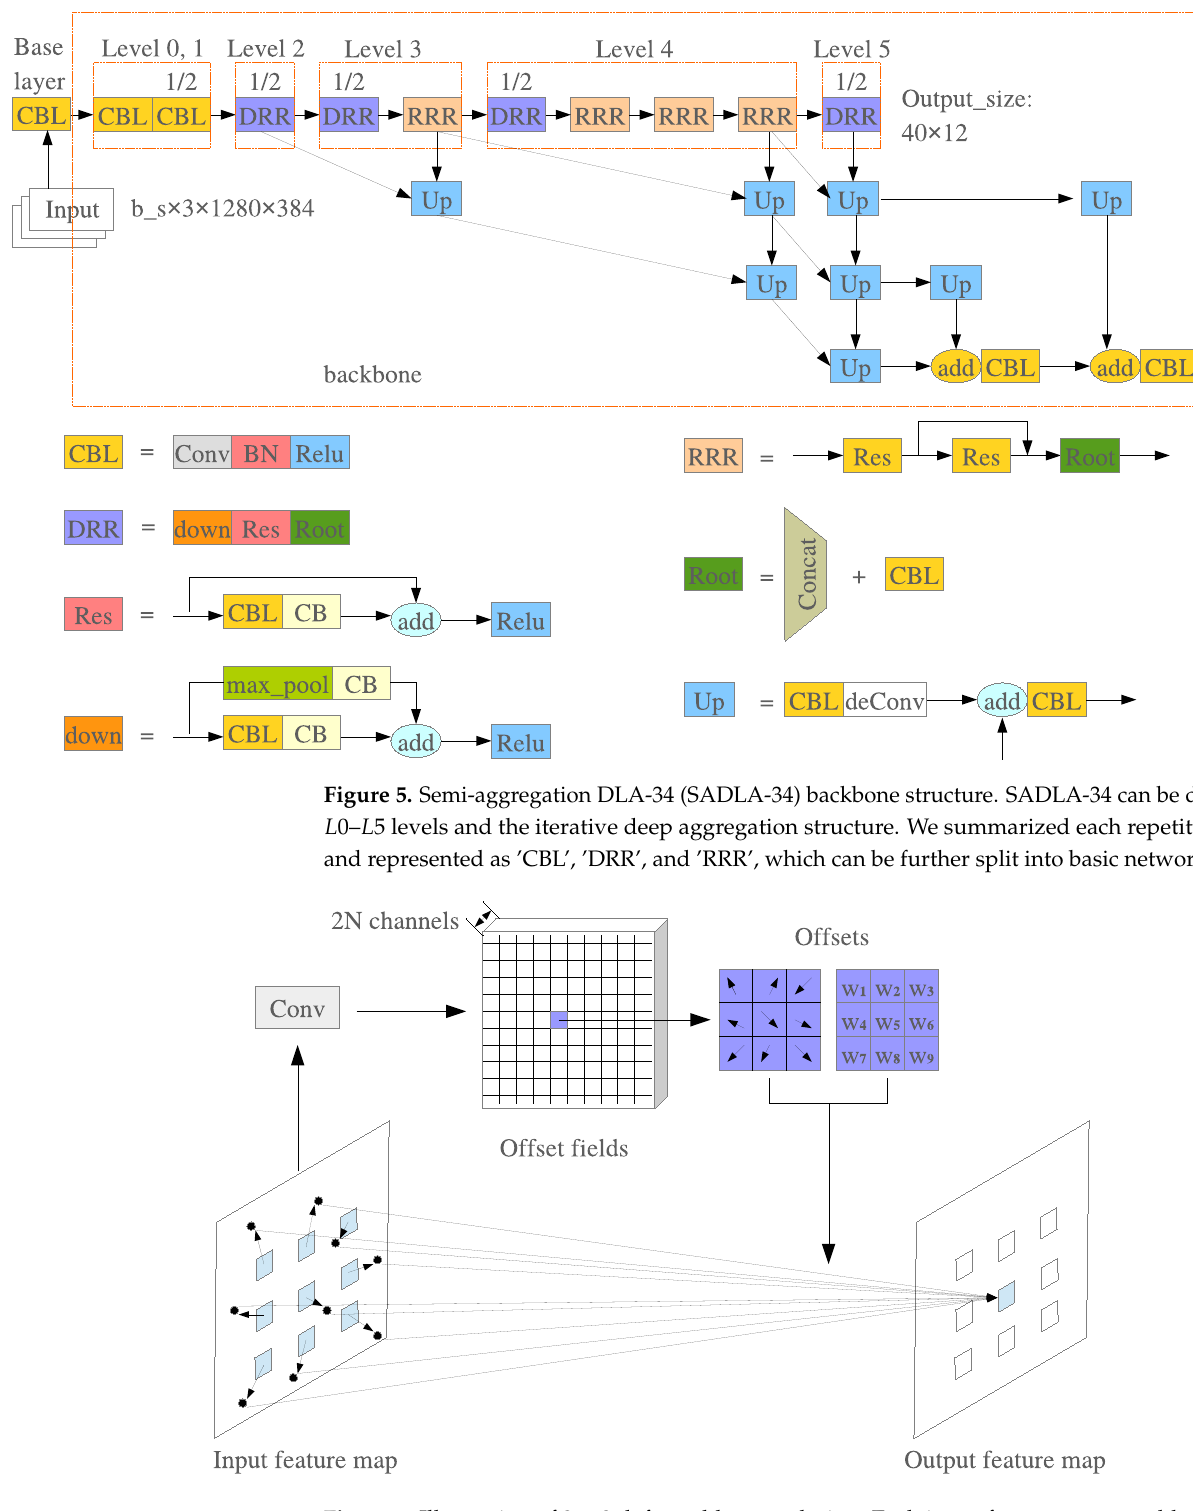
Figure 6. Illustration of 3 × 3 deformable convolution. Each input feature map would generate 2 N channels in offset fields. N denotes the number of arrows in offsets. Each arrow contains 2 variables for horizontal and vertical directions. w 1 – w 9 are additional variables representing the